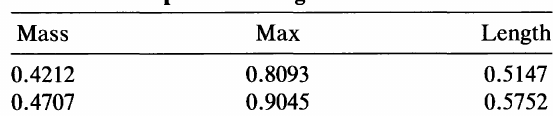
Table 3. Comparison of Eigenvectors for a -